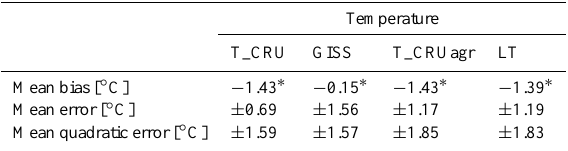
Table 2. Statistical evaluation of the differences between the ob- served and modeled data of monthly and seasonal temperatures ( ∗ significant value at α = 1%). T40 data set is used as reference data.